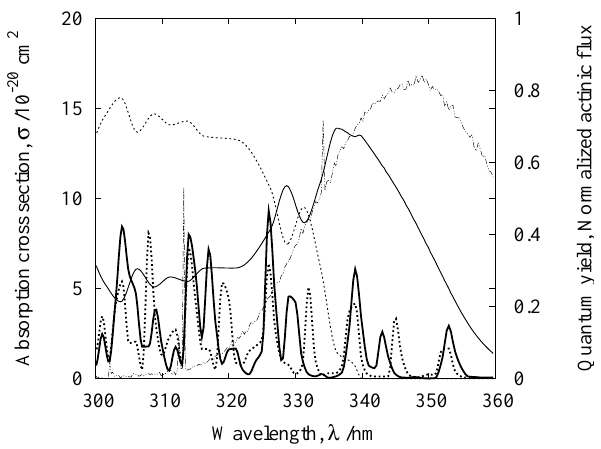
Fig. 1. Absorption cross sections of H 2 CO (thick full drawn line) and D 2 CO (thick dashed line) from Gratien et al. (2007). Also shown are the quantum yield at 1013mbar in the molecular channel (full drawn line), the quantum yield in the radical channel (dashed line) (Atkinson et al., 2006), and the emission spectrum of the Os- ram Eversun 100W/79 photolysis lamp (dash-dotted line). Table 2. Experimental relative rates, k( H 2 CO )/k( D 2 CO ) , at differ- ent chamber pressures and the initial partial pressures of the two